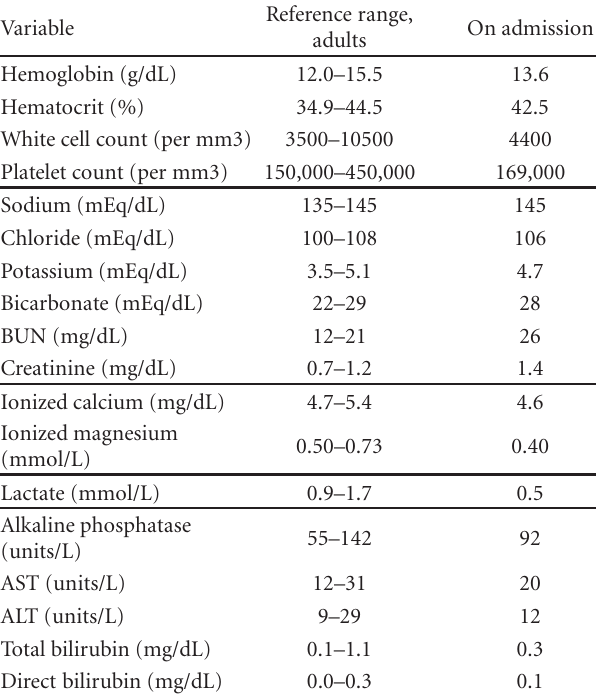
Table 1: Laboratory data.